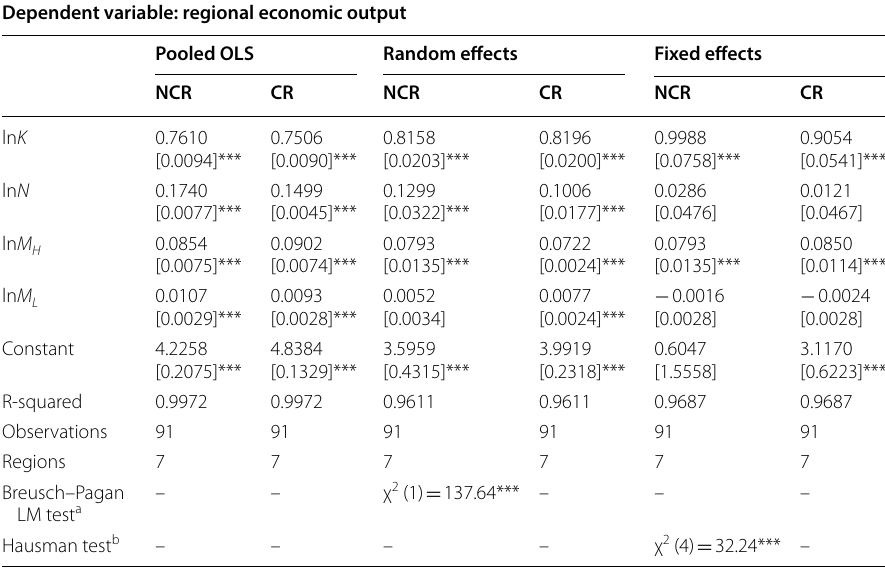
NCR and CR indicate non-constraint and constraint regression model, respectively Robust standard errors are in parentheses *, **, *** indicate significant at 10%, 5%, and 1% level of significance, respectively a Random effects versus pooled-OLS estimations test b Fixed versus random effects model